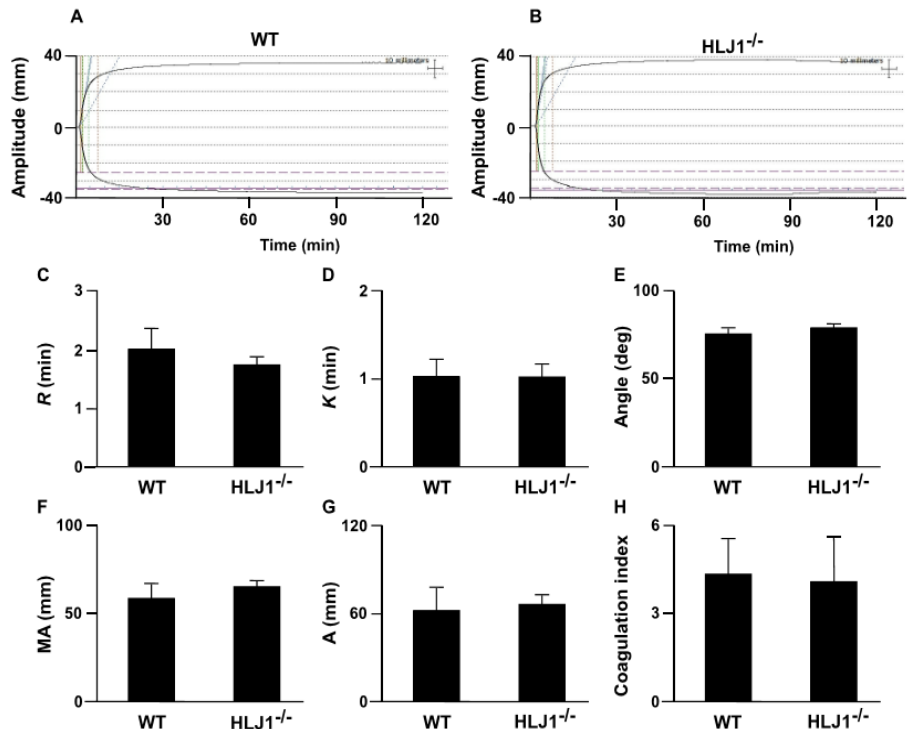
Figure 4. Thromboelastography (TEG) tracing in WT and HLJ1 -/- mice. ( A , B ) Representative tracing depicting the rate of clot formation and degradation was performed in WT and HLJ1 -/- mice. ( C – H ) The reaction time ( R ), kinetics time ( K ), α angle, maximum amplitude (MA), the end time amplitude and the coagulation index (A) were analyzed. Data are the mean ± SEM from 9 mice.